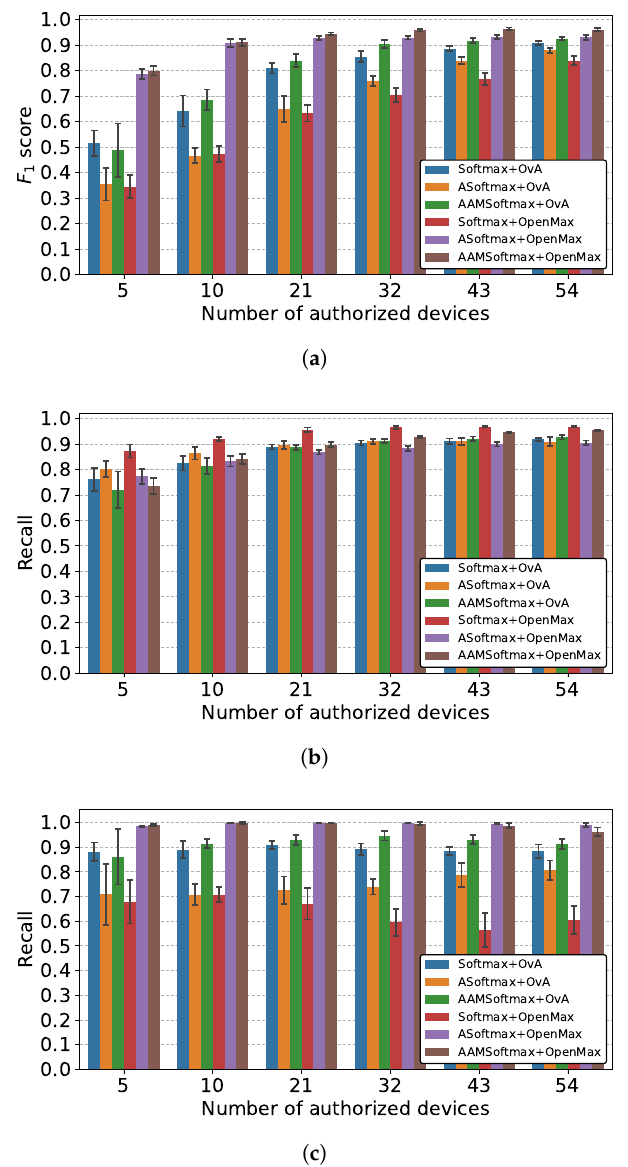
Figure 10. The performances of different combinations. ( a ) F 1 score of all devices; ( b ) Recall of authorized devices; ( c ) Recall of unknown